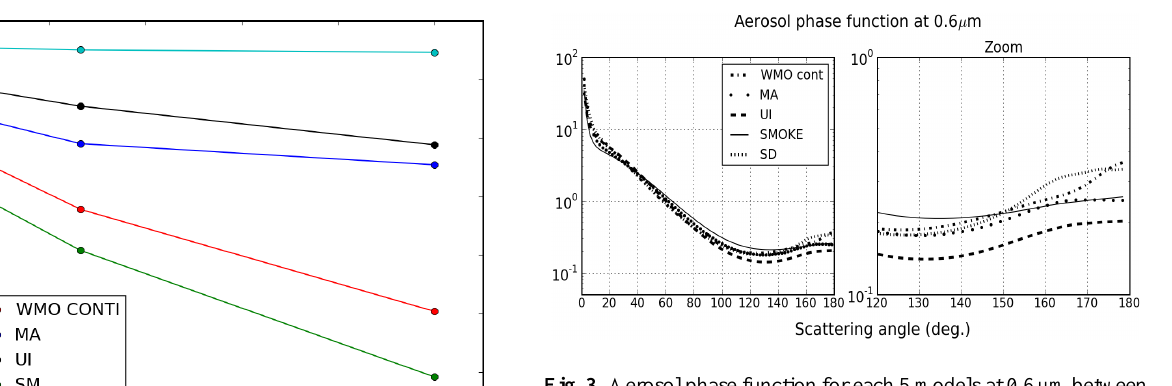
Fig. 3. Aerosol phase function for each 5 models at 0.6 µ m between 0 ◦ and 180 ◦ (left). A zoom for the backscattering part (from 120 ◦ to 180 ◦ ) is also plotted (right).